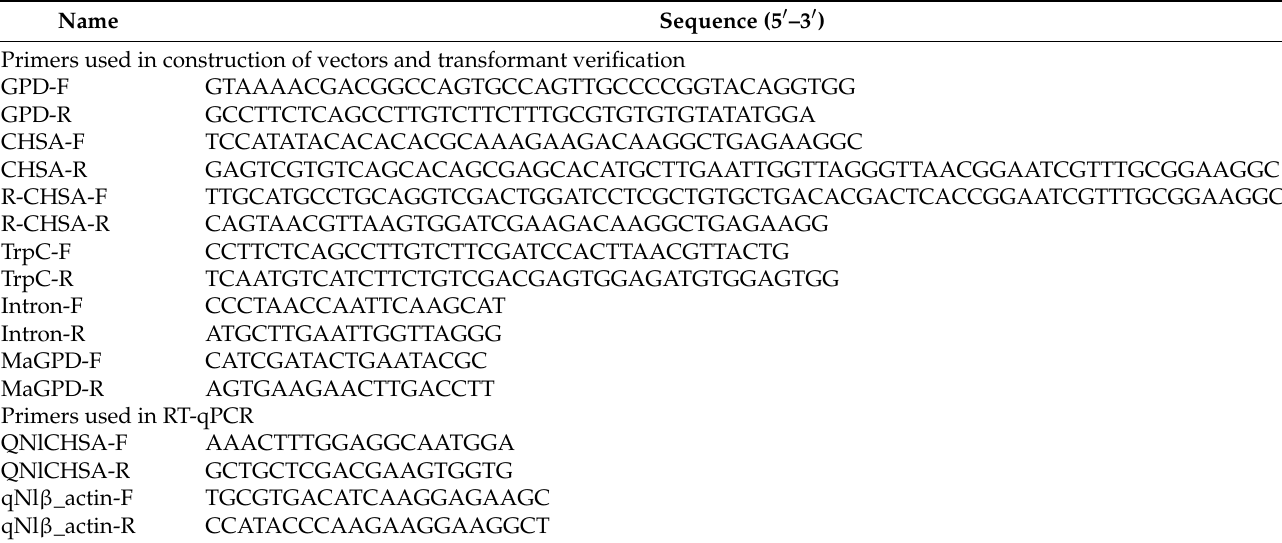
Table 1. Primers used in this